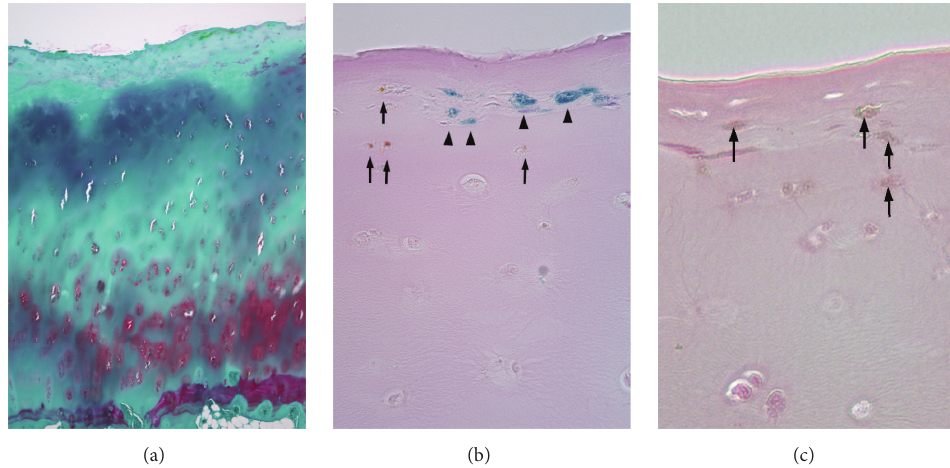
Figure 3: Histological findings. (a) In the lateral femoral condyle bone, safranin O staining of the cartilage lesion is reduced at the transitional and radial zones. (b) Berlin blue staining reveals hemosiderin deposition (arrowhead) in the superficial articular cartilage, and (c) lipofuscin (brown granules that are indicated by the arrows) deposition is also visible in the superficial articular cartilage via Fontana Masson